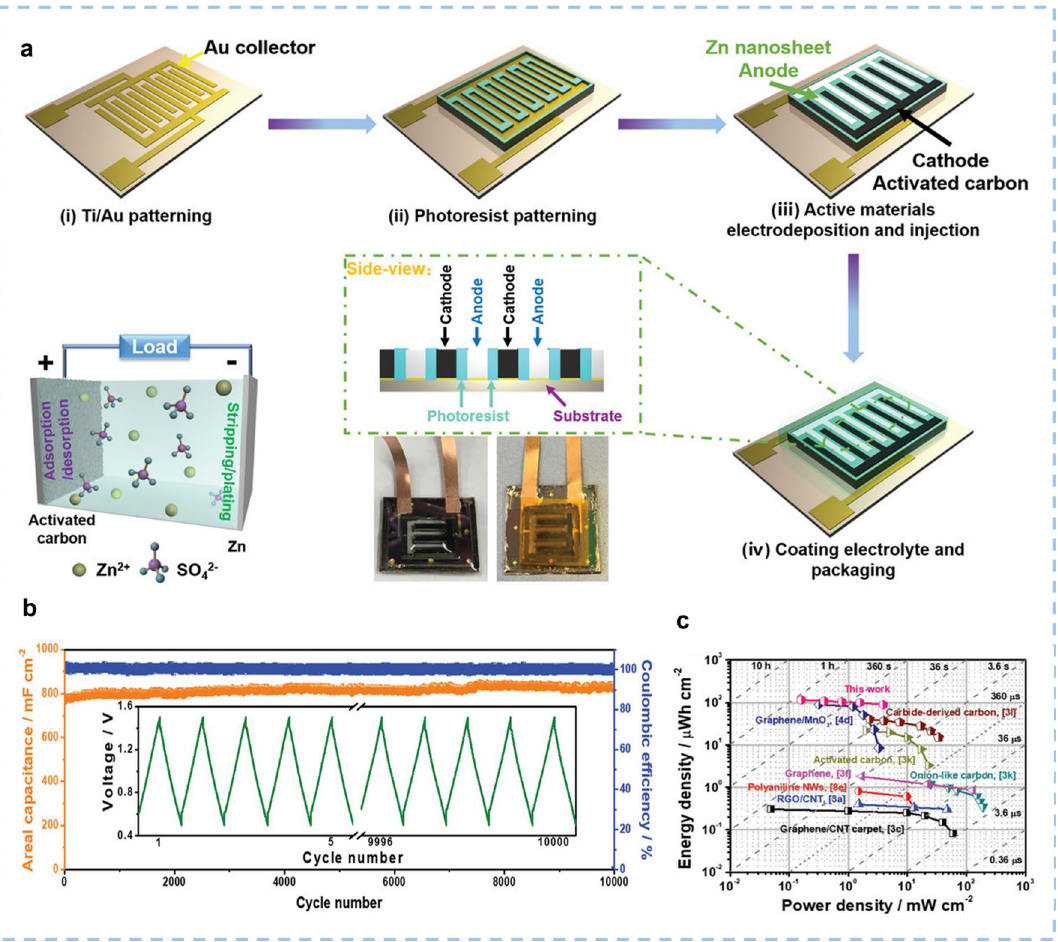
Fig. 13 Fabrication process and the electrochemical behavior of the Zn-ion hybrid MSCs. a Schematic of the fabrication process of Zn-ion hybrid MSCs b Cycling stability at the current density of 1.56 mA cm −2 . Inset shows the first five and the last five GCD curves of Zn-ion hybrid MSCs. c Ragone plots for Zn-ion hybrid MSCs, carbon-based MSCs, graphene-based MSCs, and conducting-polymer-based MSCs. Reproduced with permission [15]. Copyright 2018,